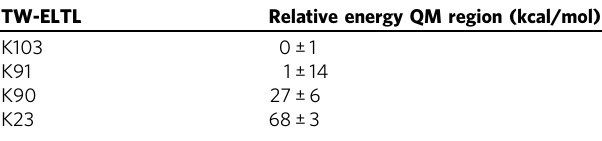
Table 1 The relative energies of the QM region indicate that the tweezer – lysine complexes are most stable in positions 103 and